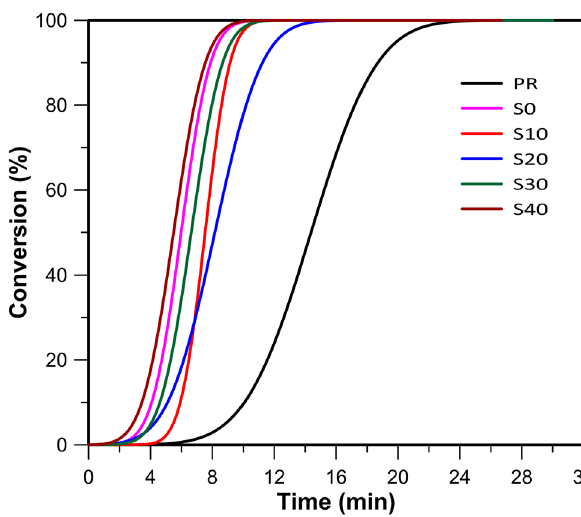
Figure 2: Degree of conversion vs time at